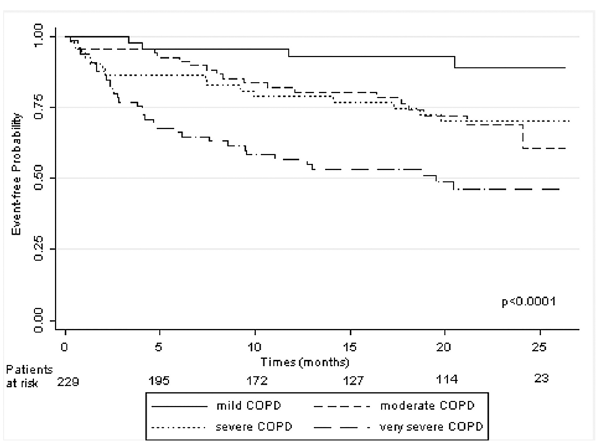
Fig 1. Kaplan-Meier analyses show that there is a significant difference between survival curves by COPD stage. The very severe COPD group has a lower event-free probability than subjects in the other stages. The mild COPD group has the highest event-free